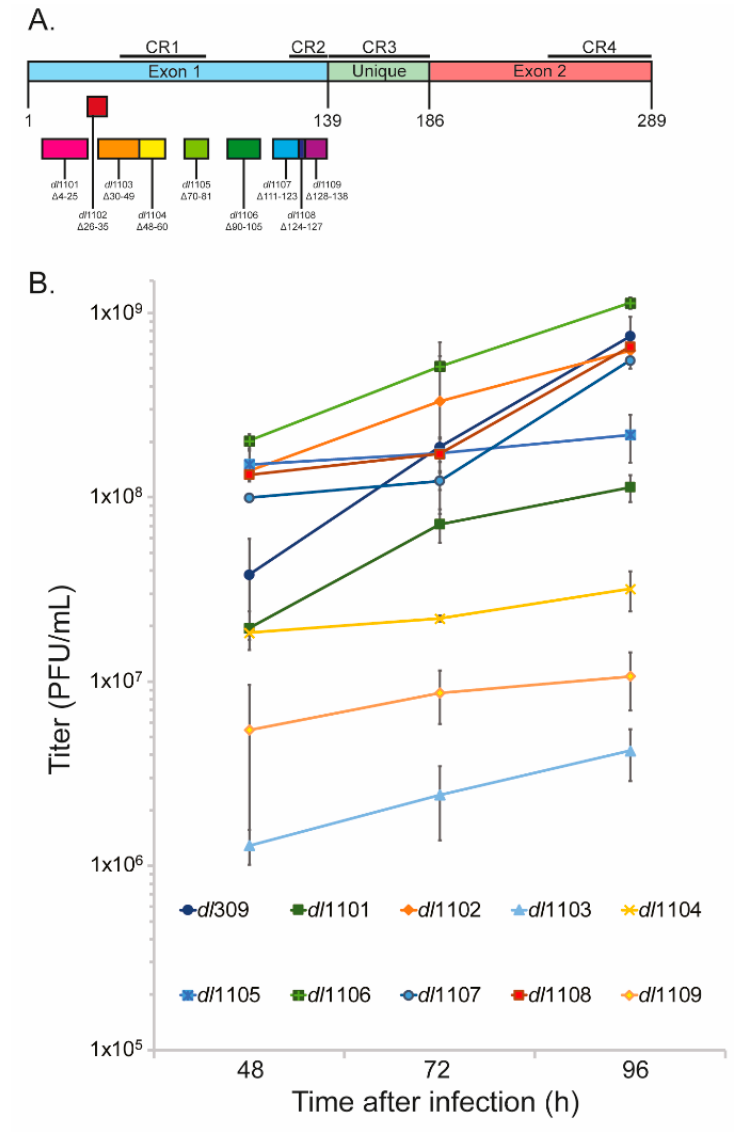
Figure 1. Deletions within E1A exon 1 affect virus growth in primary lung fibroblasts. ( A ) Schematic representation of E1A mutants used in this study. ( B ) WI-38 cells were grown until fully confluent at which point medium was replaced and cells were incubated for 72 h before infection with the indicated viruses at a multiplicity of infection (MOI) of 100. Virus growth was subsequently evaluated by harvesting cells at the indicated time ‐ points, followed by 3 rounds of freeze ‐ thaw to liberate viral particles, and titration on 293 cells by plaque assay. Error bars represent standard deviation of three biological replicates. p ‐ values for differences between given time points is as follows: 48 h, all were significant versus dl 309 with a p ‐ value of <0.0001; 72 h, dl 1102 and dl 1108 were not significant with regards to dl 309, all others were with a p ‐ value of ≤ 0.0329; 96 h, all were significant with a p ‐ value < 0.0001.